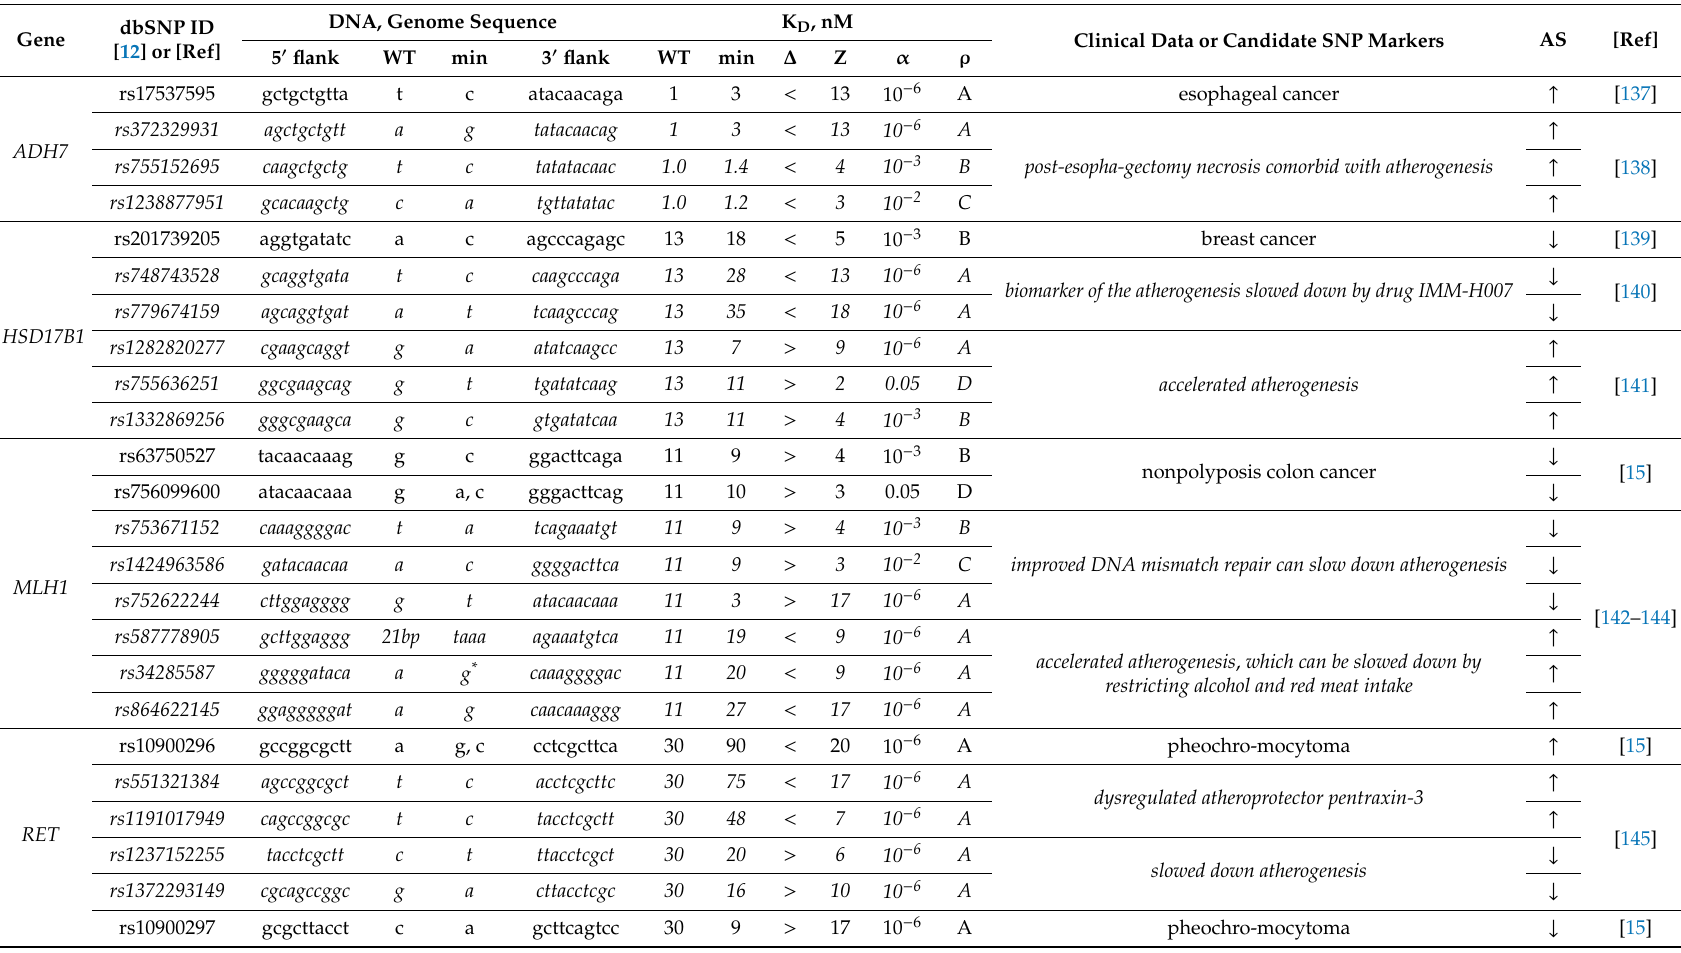
Table 6. Atherogenesis-related candidate SNP markers within the gene promoters where SNPs of TBP-sites are clinically linked with cancers.